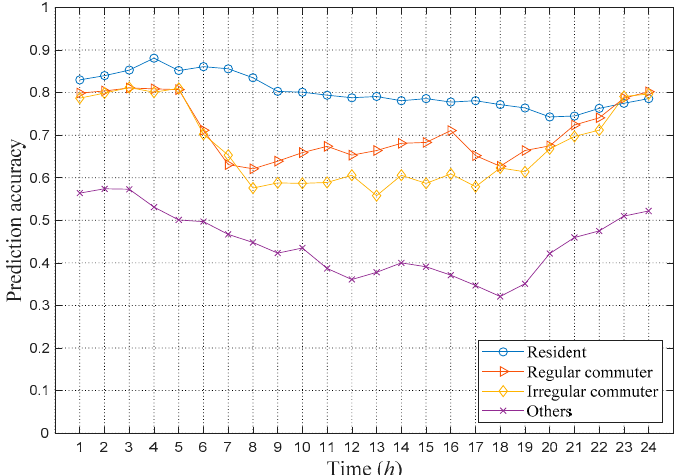
Figure 6. Prediction results of the weighted Markov model based on different user classifications.